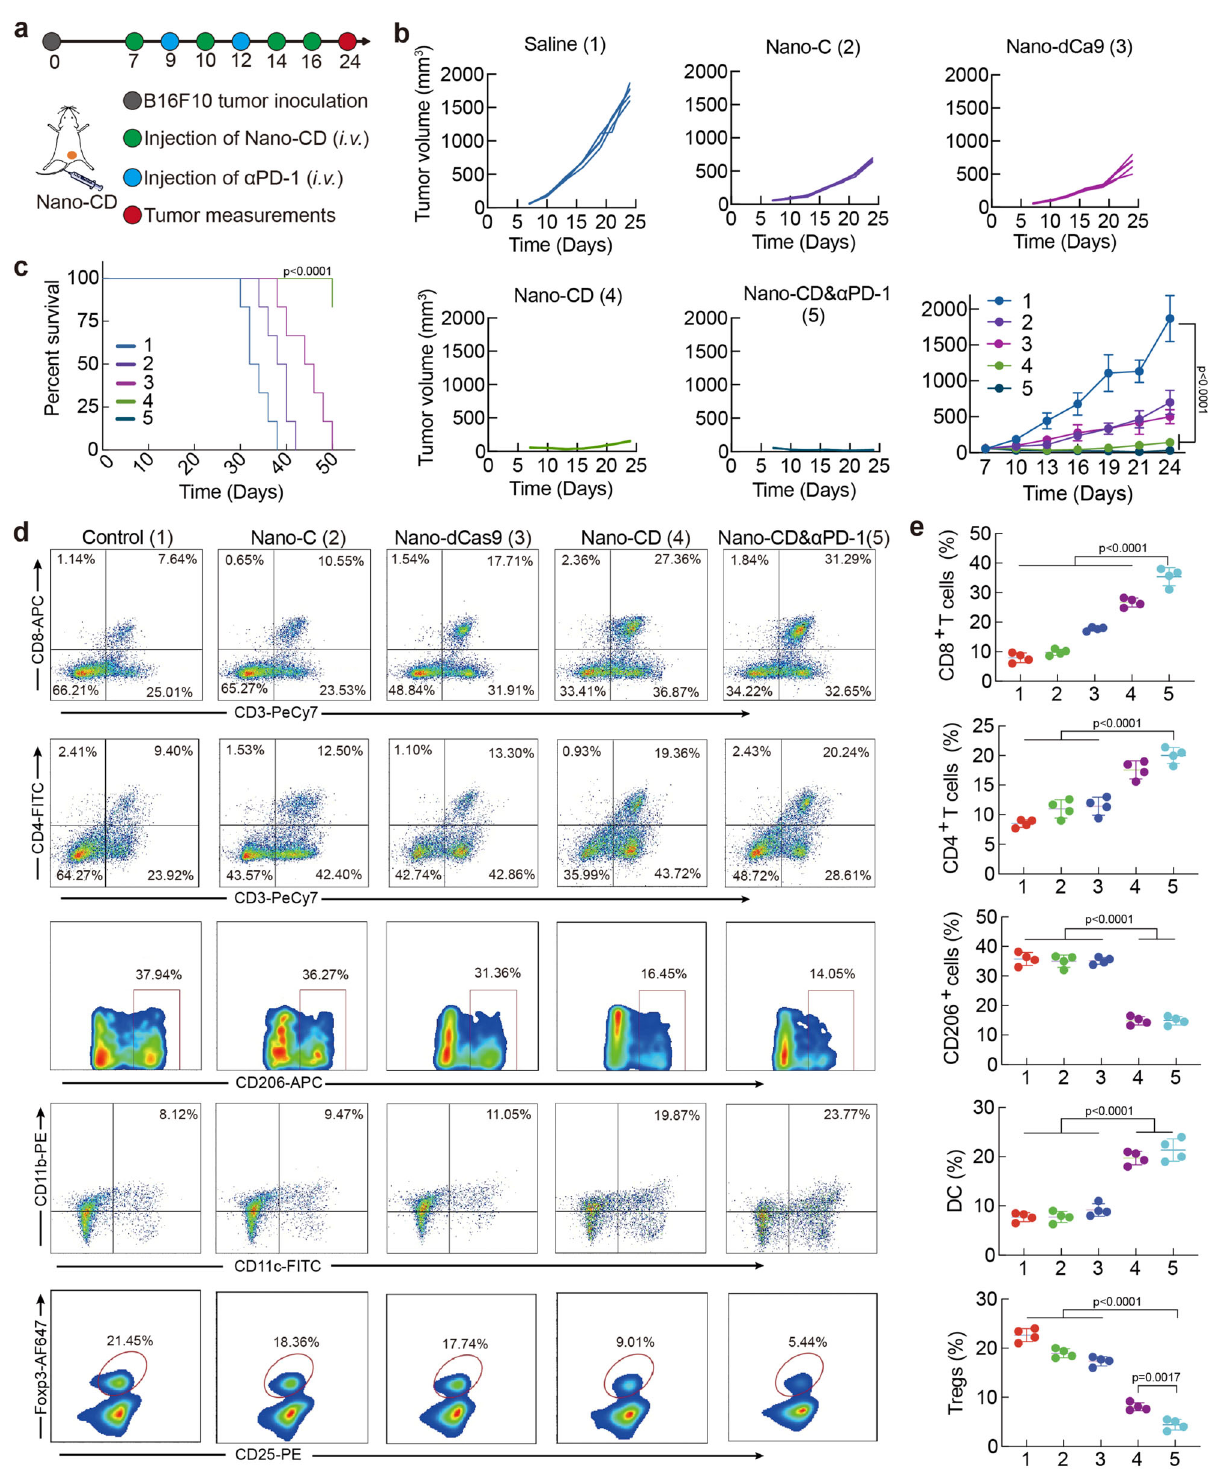
Fig.5|Anti-tumoreffectofNano-CDagainstprimarymelanomamodel.a Time schedule of the treatment. b , Individual tumor growth curve and average tumor curve during treatment Data are presented as the mean ± s.d. ( n =5 biological replicates per group). c Survival rate per group. (log-rank test, n =6 biological